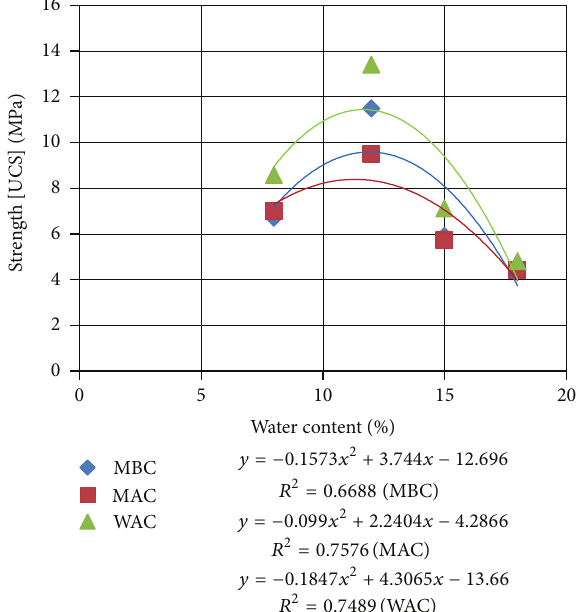
Figure 17: UCS for different water contents (4% cement) (dry durability condition).